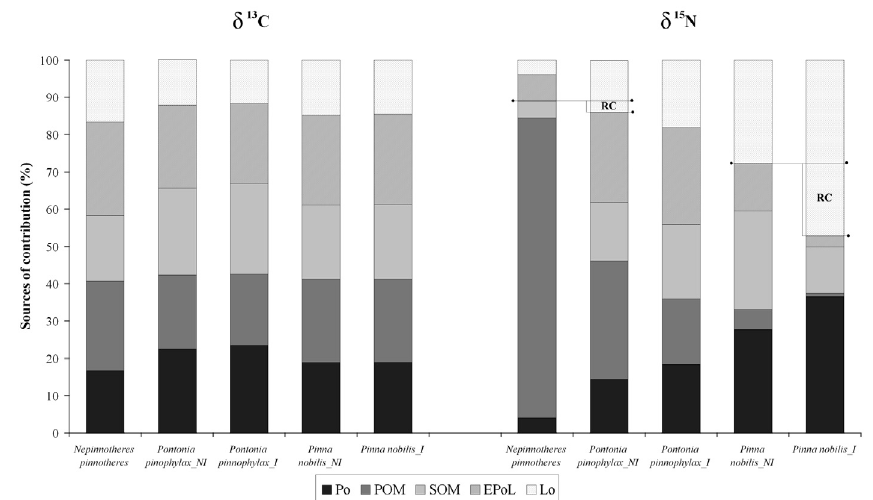
Fig . 3. – Mean values of potential food sources contribution (%) to the δ 13 C and δ 15 n diet of the fan mussel Pinna nobilis , the shrimp Pontonia pinnophylax and the pea crab Nepinnotheres pinnotheres in an invaded and non-invaded situation. i: invaded; ni: non-invaded; Po: Posidonia oceanica ; PoM: Particulate organic matter; soM: sediment organic matter; ePol: epiphytes of Posidonia oceanica leaves; lo: Lophocladia lallemandii . The real contributions (RC) of L. lallemandii are delimited by the dashed